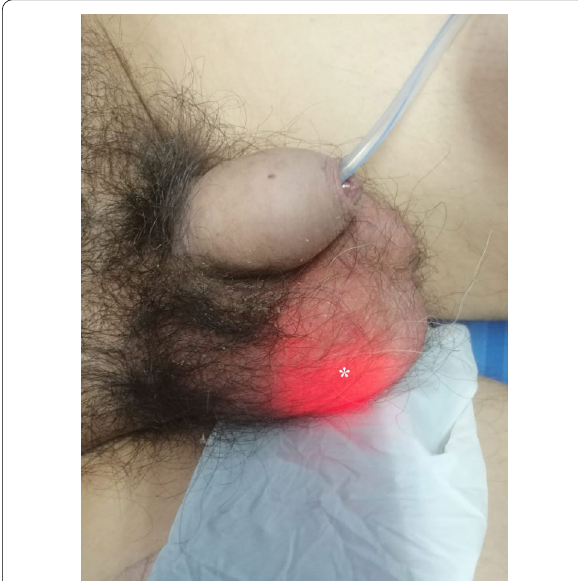
Fig. 1 Positive transillumination test for the right hemiscrotum. * Right hemiscrotum